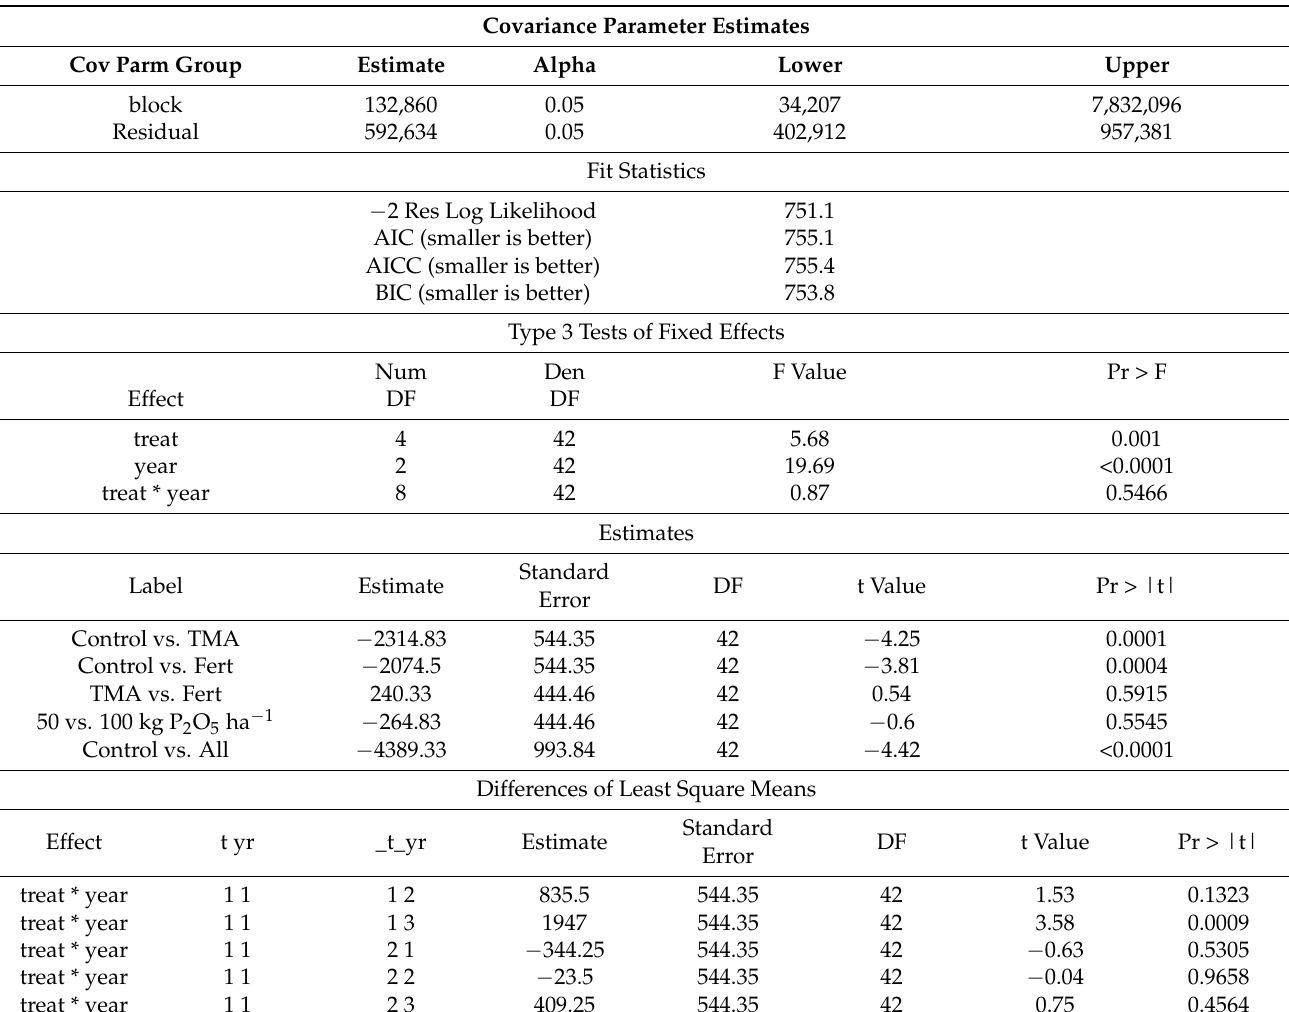
Table 1. Output 1: Partial output of the statistical analysis of the corn study with year treated as a fixed effect